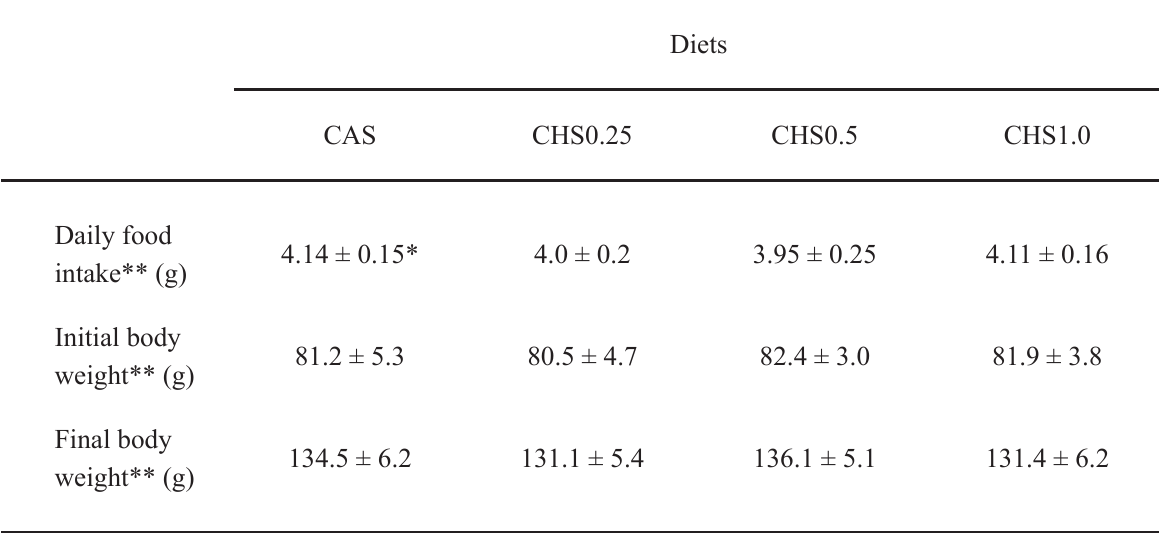
Table I. Daily food intake and body weight gain of rats fed on r-chagasin diets (CHS0.25, CHS0.5 and CHS1.0, corresponding to 0.25%, 0.5% and 1.0% of total protein, respectively) and control diet (CAS), containing casein as the sole source of protein, for 10